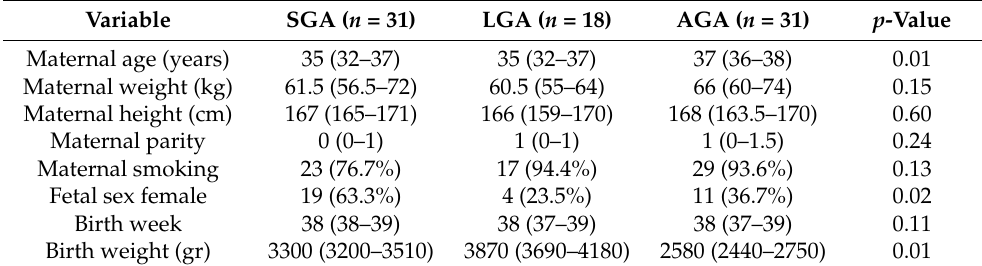
Table 1. Maternal and fetal characteristics of the studied groups (SGA, LGA, and AGA) (values presented as median and Q1–Q3 range and for categorical data as number of cases and percentage).